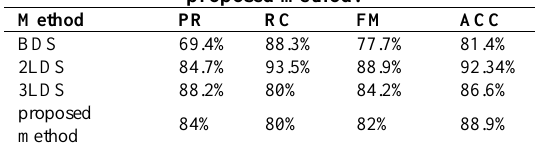
Table 8. Comparison of BDS, 2LDS, 3LDS, and the proposed method.